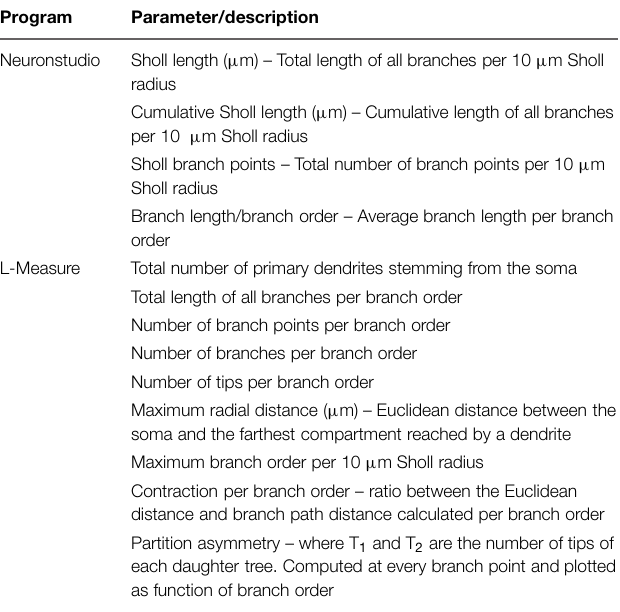
TABLE 2 | Morphological parameters analyzed from 3D neuronal reconstructions.